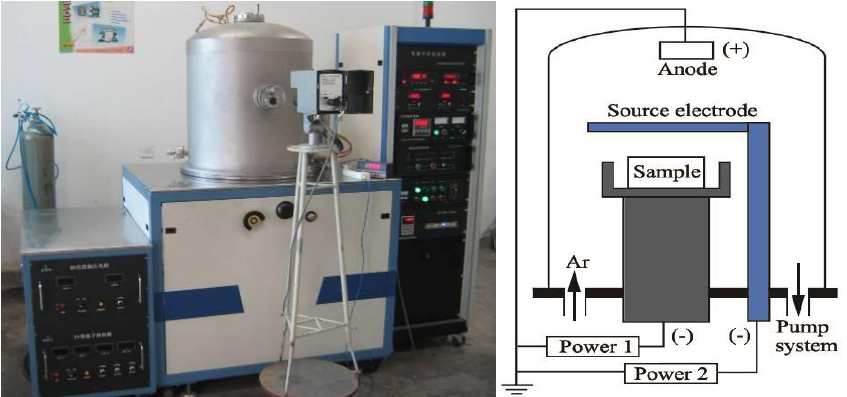
Figure 1. Schematic of the double glow plasma carburizing system and the equipment. Table 1. Processing parameters of double glow plasma carburizing.